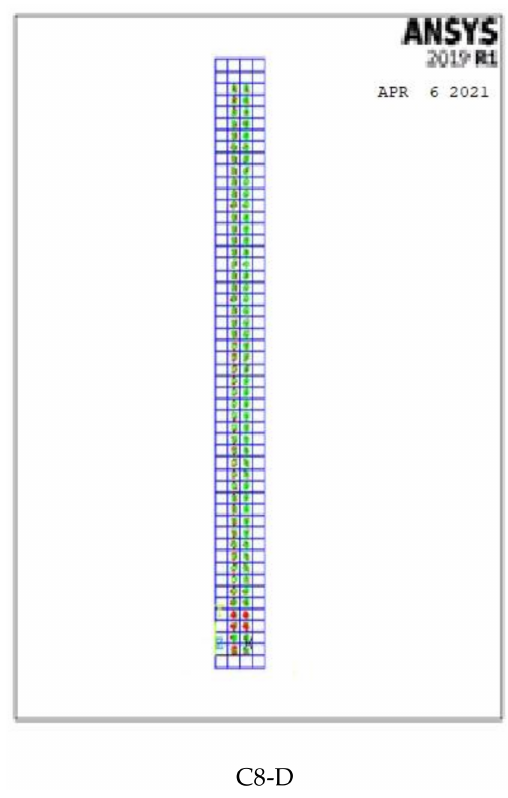
Figure 18. Crack patterns for the modeled